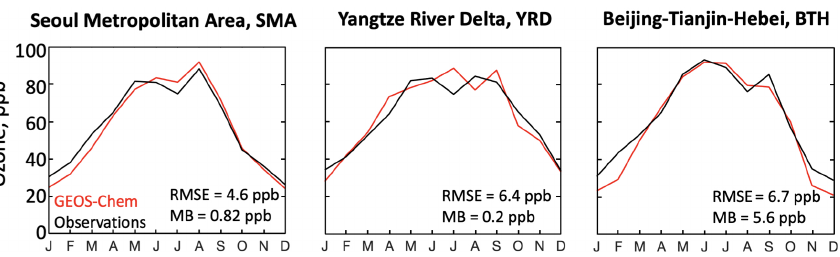
Figure 8. Seasonal variation in monthly 90th percentile MDA8 ozone in three megacity clusters in 2016. The clusters are the Seoul metropoli- tan area (SMA; 37.2–37.8 ◦ N, 126.7–127.3 ◦ E), the Yangtze River Delta (YRD; 30–33 ◦ N, 118–122 ◦ E) and Beijing–Tianjin–Hebei (BTH; 37–41 ◦ N, 114–118 ◦ E). GEOS-Chem results are compared to observations, and the corresponding root mean square error (RMSE) and mean bias (MB) are shown inset. The 90th percentiles are computed from the time series of spatial mean concentrations for each cluster, with GEOS-Chem sampled at the network sites.